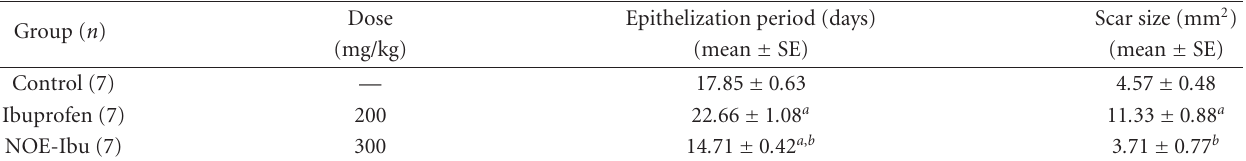
Table 3: E ff ect of ibuprofen and NOE-ibuprofen on epithelialization and scar size (by Sche ff e’s test—SPSS computer package). ( n = number of animals.) The di ff erence between any two means is statistically significant if the mean di ff erence is more than the allowance value calculated.